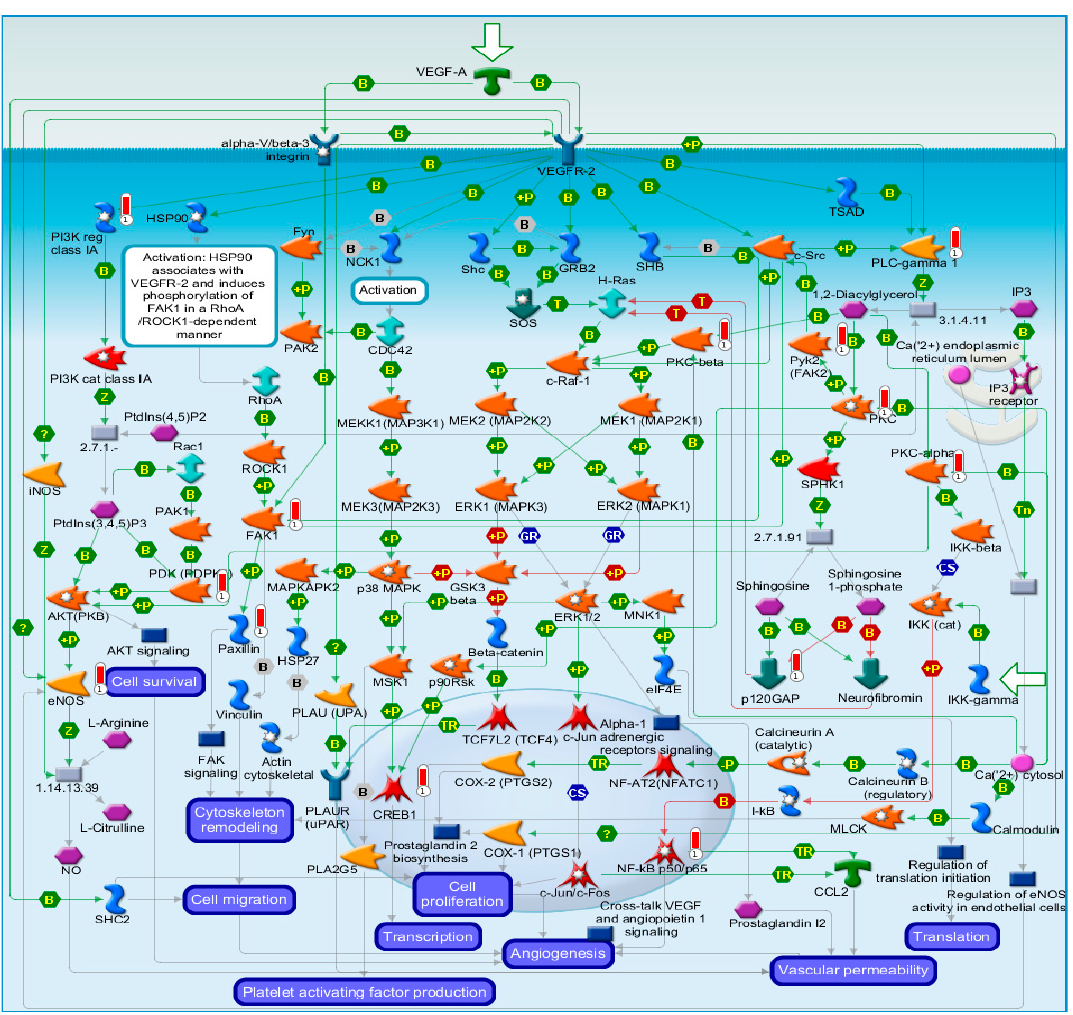
Figure 1. Pathway analysis map showing VEGF signaling via VEGFR-2 generic cascades. Experimental data are projected onto and visualized on the maps as thermometer-like figures. Upward thermometers are shown in the red color and indicate upregulated phosphorylation levels of the proteins (key of the map: Supplementary Material Figure S1).